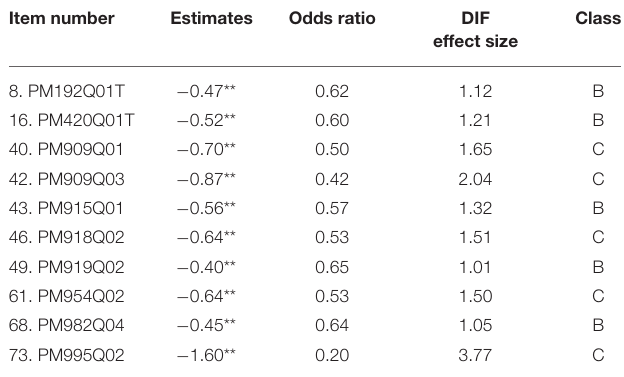
TABLE 4 | Summary of HGLM Model 1.